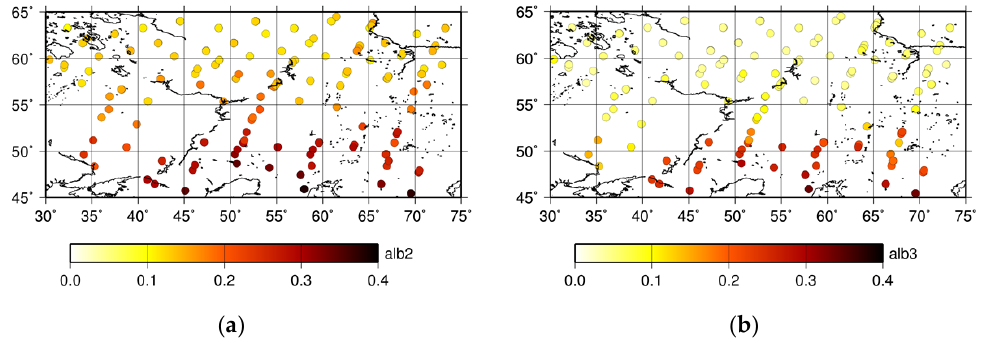
Figure 10. Distribution of the averaged surface albedo in the spectral bands of the GOSAT sensor at around 1.6 μm ( a ) and 2 .0 μm ( b ).